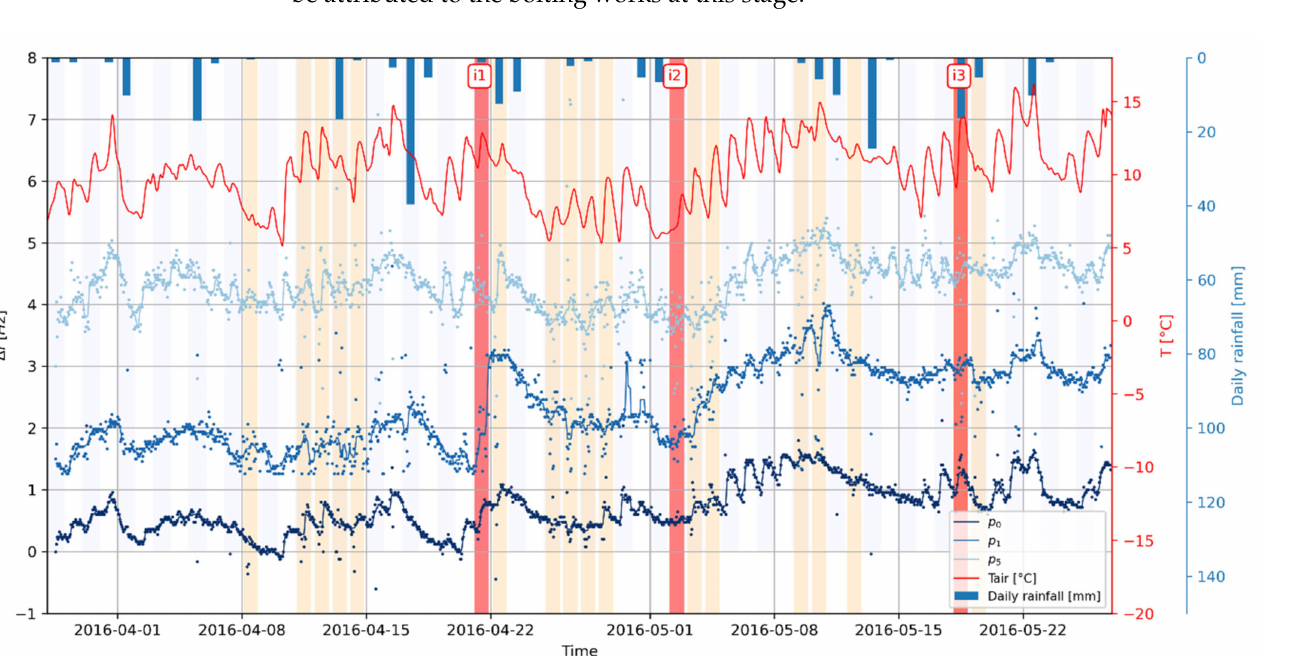
Figure 5. Variations in HVSR peak frequencies p 0 , p 1 , and p 5 over time (frequencies have been arbitrarily shifted for the sake of easier comparison, labeled ∆ f ). Continuous lines show the rolling median computed on 12 h long windows. Air temperature on-site is shown as red curve, and daily rainfall is shown as blue bars (downwards axis). Reinforcement work stages are shown in the background: drilling days (light orange) and grout injection